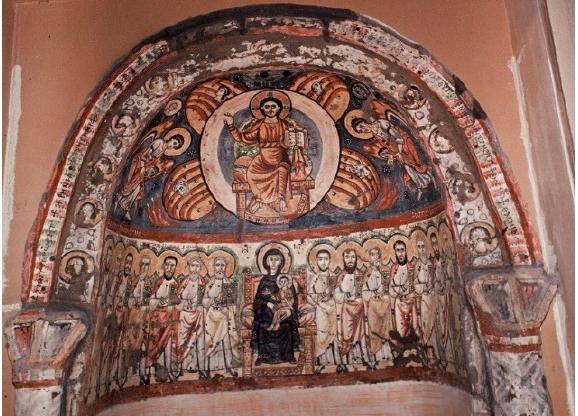
Figure 14. Bawit (Egypt), chapel 17. Aquarelle copy. After Clédat (1904) vol. 1, part two. pl. XLI.